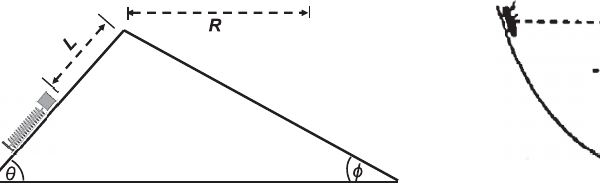
1. Two sequential synthesis